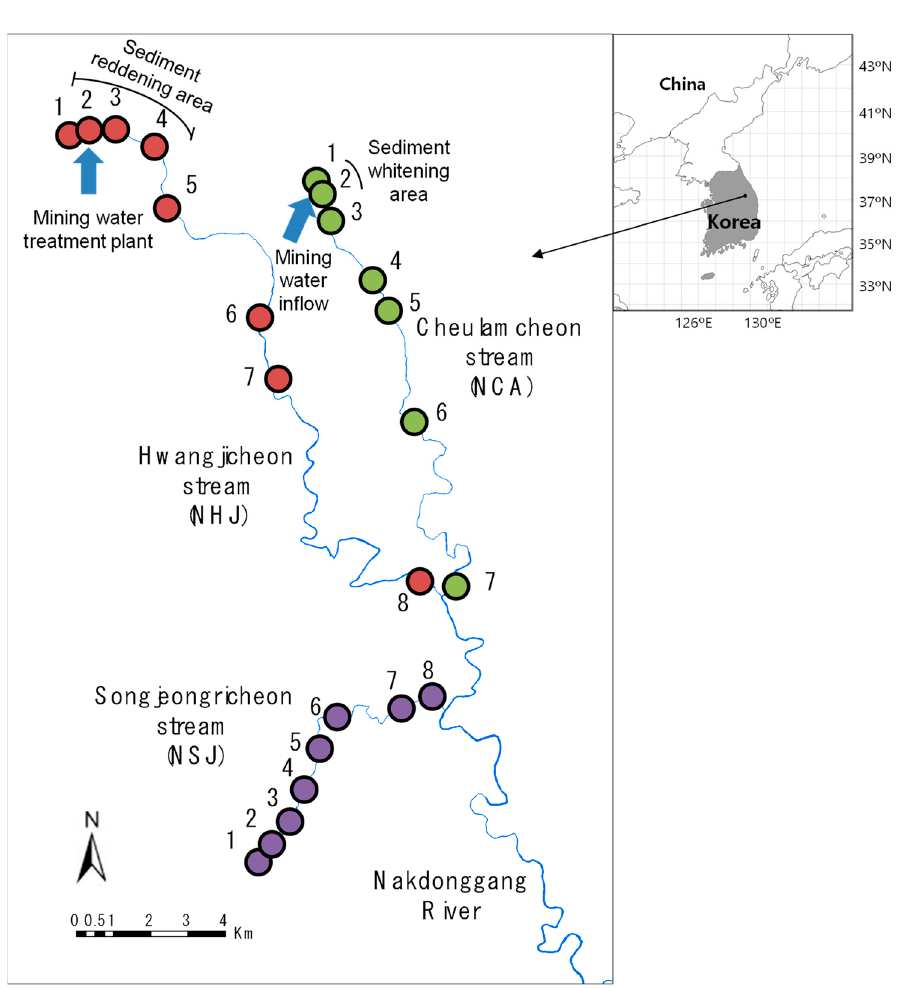
Figure 1. Sampling sites in three streams. Numbers 1 to 8 in each stream indicate sampling